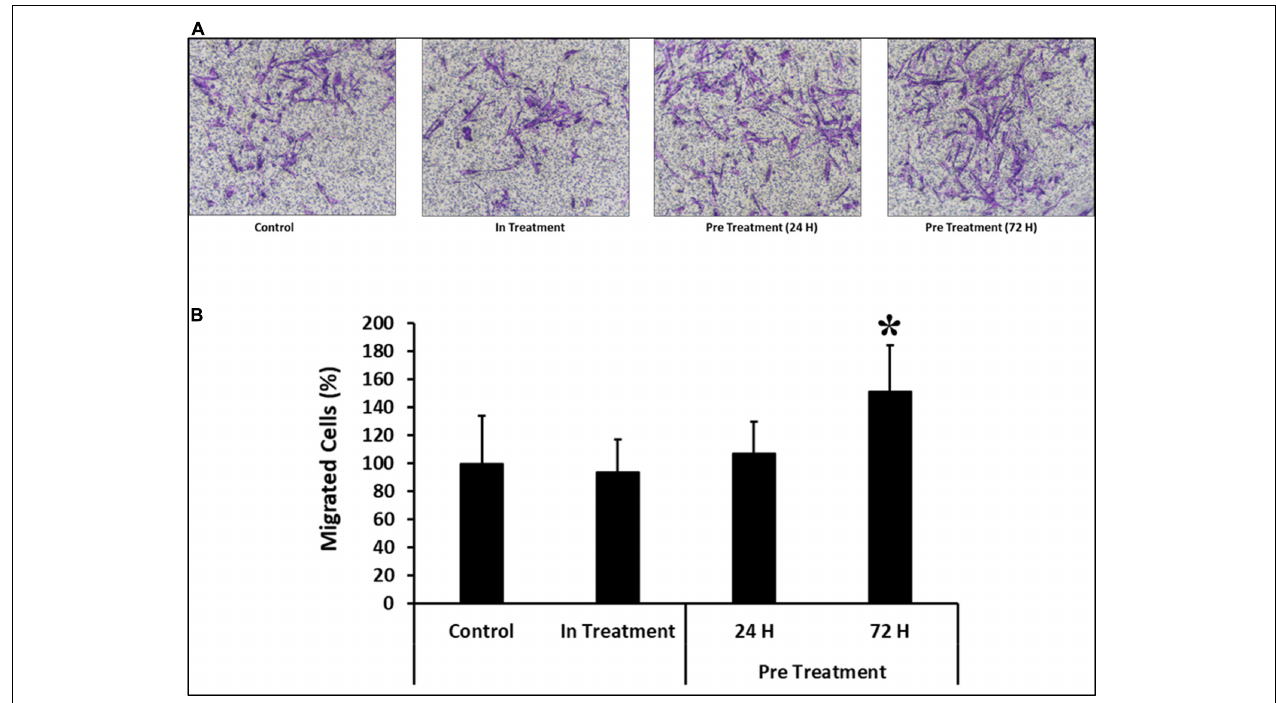
FIGURE 5 | Comparison of functional outcome of CV-MSCs before and after CM-MDA231 preconditioning. Migration of CV-MSCs before and after preconditioning along-with in-treatment was further evaluated by transwell assay. CV-MSCs preconditioned with CM-MDA231 for 24 h, migrated at a significantly faster rate through the 8 µ M pore of a transwell filter as compared to the cells treated for 24 h treatment, in-treatment and untreated control. (A) Shows the photomicrograph of the migrated cells under various treatment conditions. Five different fields were counted and the percentage of total migrated cells are presented in a bar graph (B) . Cells isolated from five individual placentae were used in these experiments, which were repeated three times. Bars represent standard errors * P ≤